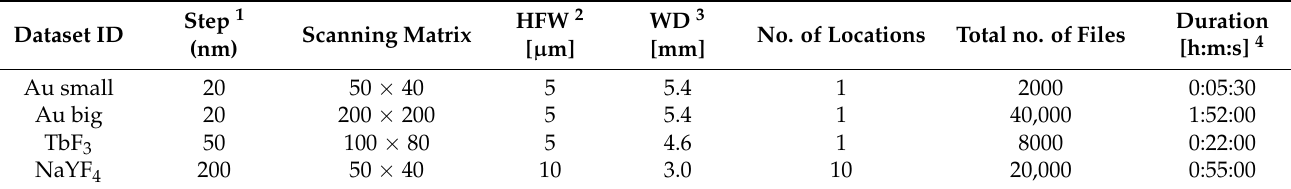
Table 1. Data acquisition